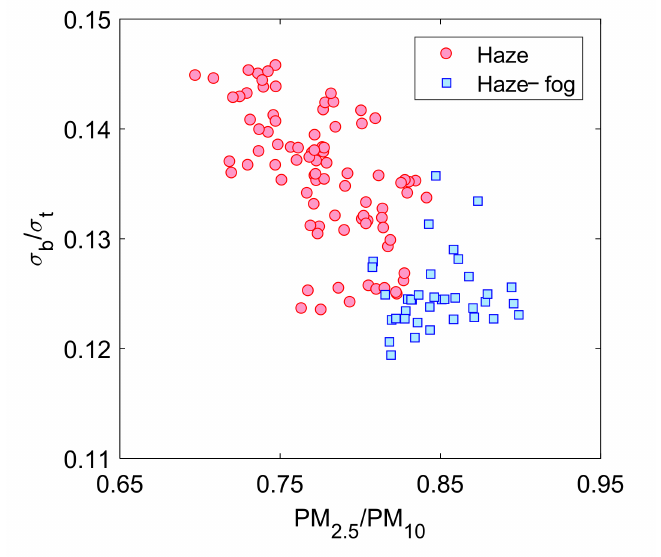
Figure 6. Relationship between the ratio of hourly mean aerosol backward to total scattering coeffi- cients ( σ b / σ t ) at 525 nm observed at the IAE station and the ratio of PM 2.5 to PM 10 mass concentra- tions in Shenyang during the haze and haze–fog mixed episodes.